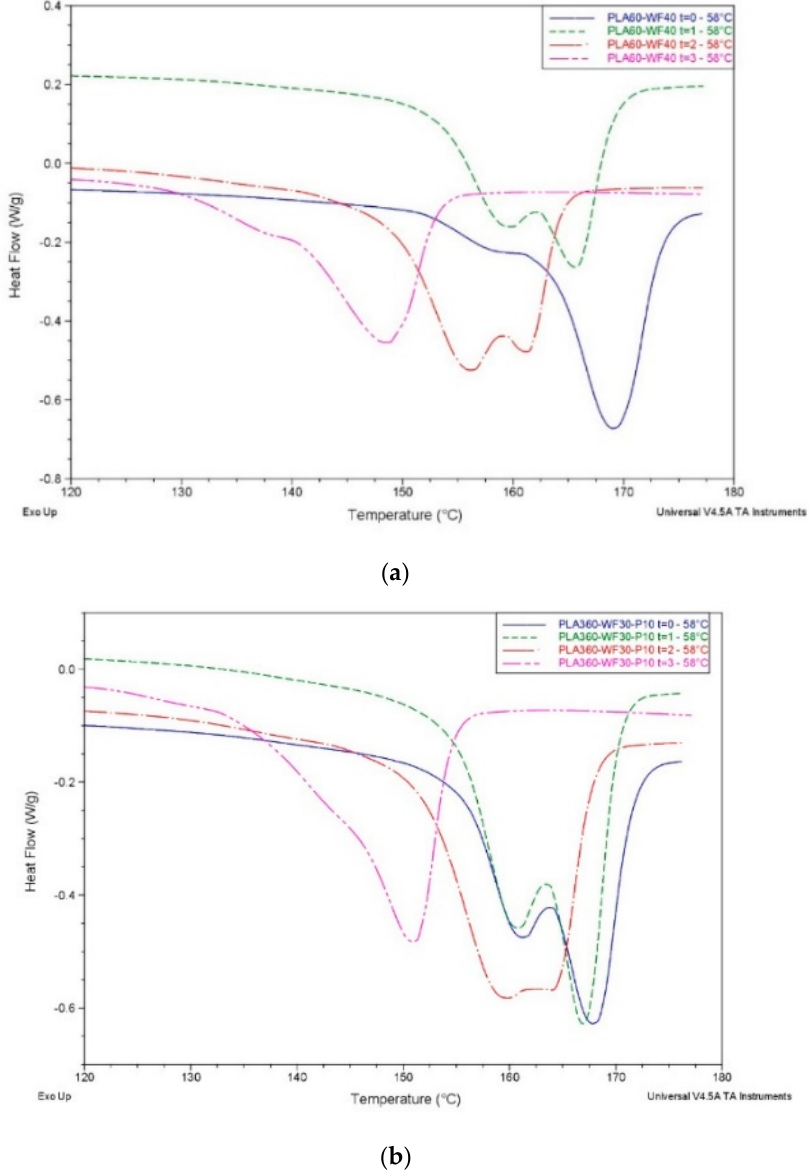
Figure 6. Melting peak of PLA60-WF40 ( a ) and PLA60-WF30-P10 ( b ) composites during composting process at 58 °C.